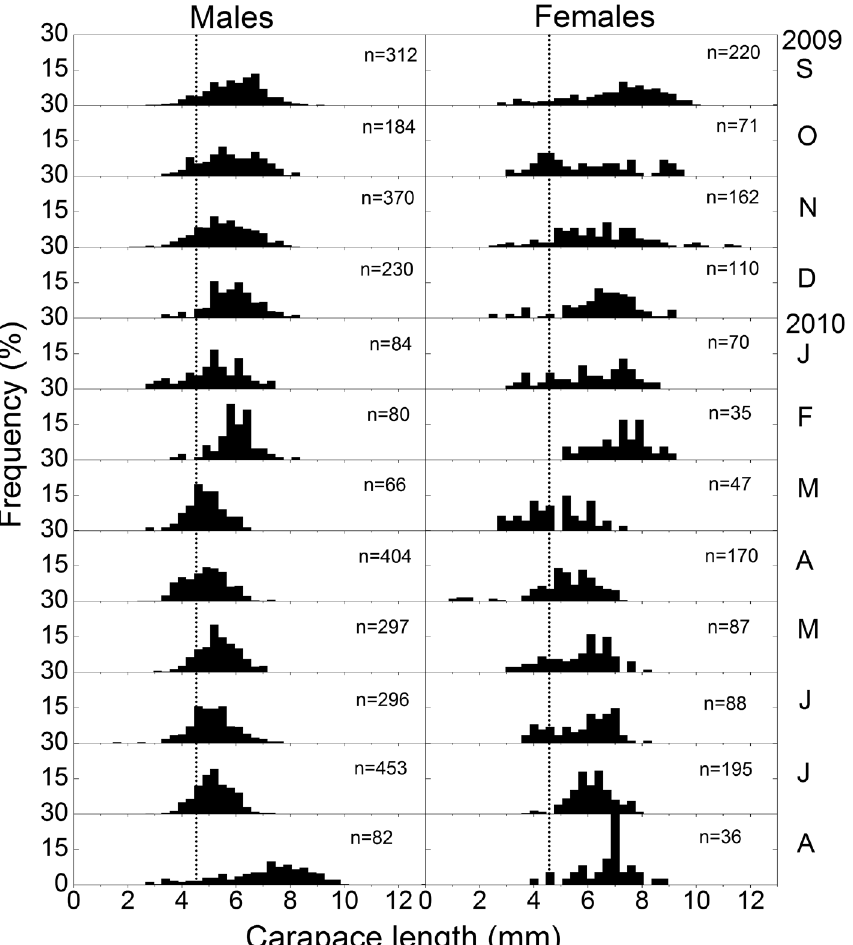
Figure 6. Monthly length frequency distribution of males and females of Palaemon pandaliformis collected from September 2009 and August 2010 in Rio Salsa, Canavieiras, Bahia, Brazil. Dotted line at 4.53 mm was drawn for illustrative purposes, indicating recruitment of small individuals into the population, according to P aschoal et al. (2013b).